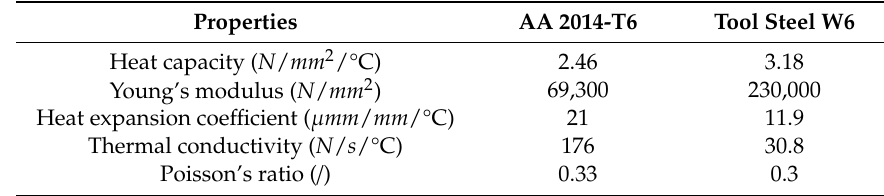
Figure 4. Flow stress curve of the 2A14 aluminum alloy. Table 2. Thermal characteristics of the 2A14-T6 workpiece and W6 tool.